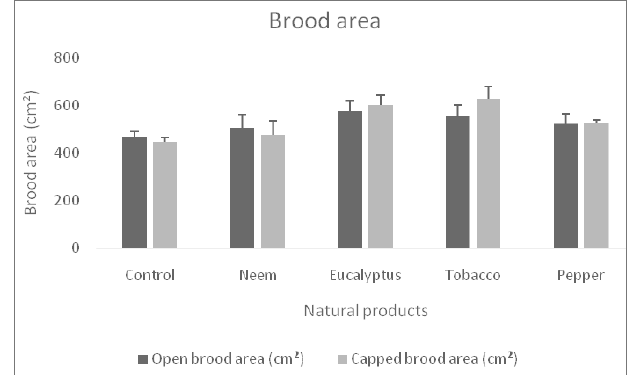
Fig 3. Population growth of A. mellifera colonies after using the different natural